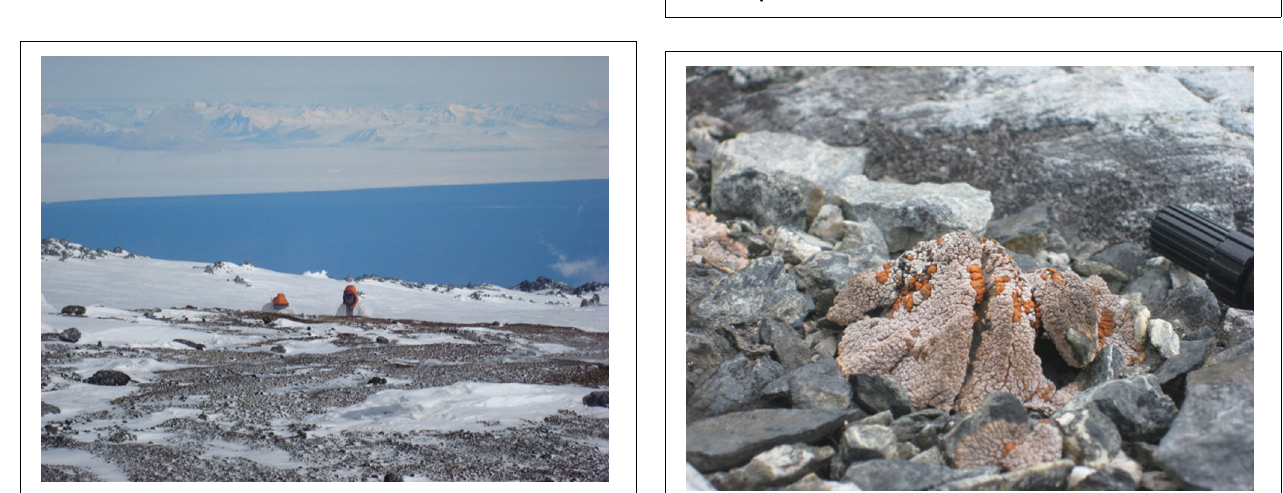
FIGURE 8 | Mixed lichen communities (including genus Alectoria ) at the north of the Antarctic peninsula (Alectoria Island).